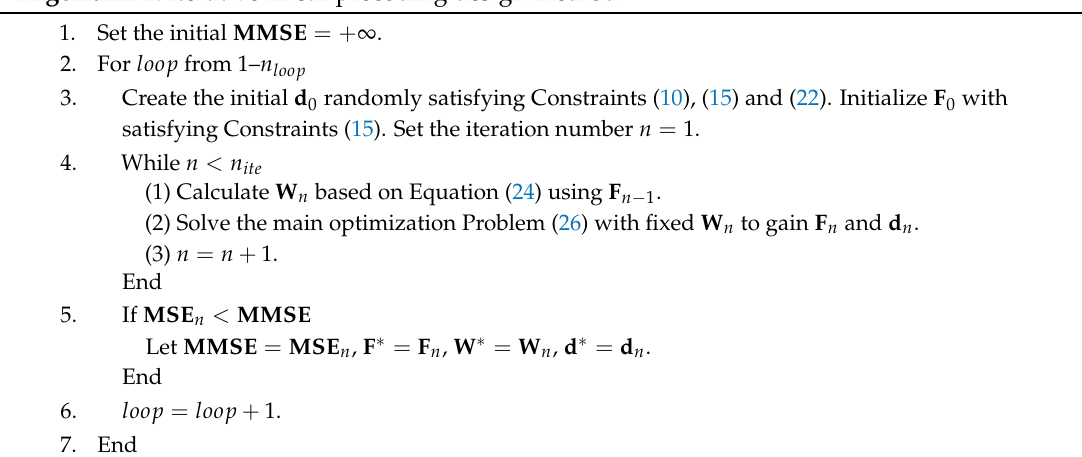
Algorithm 1: Iterative linear precoding design